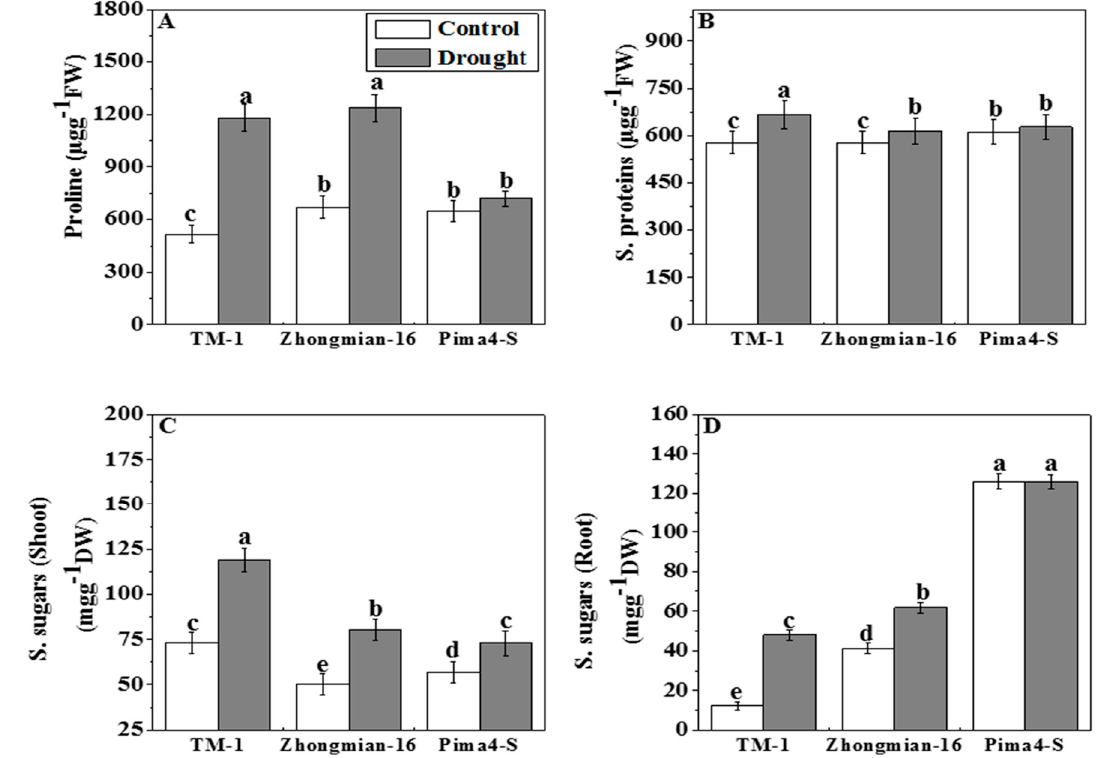
Figure 4. Effects of drought on proline ( A ); soluble proteins ( B ); soluble sugars (Shoot) ( C ) and soluble sugars (Root) ( D ) contents in leaves of three cotton species. Means denoted by the same letter are not significantly different at p < 0.05. Error bars are ± SD ( n = 4).